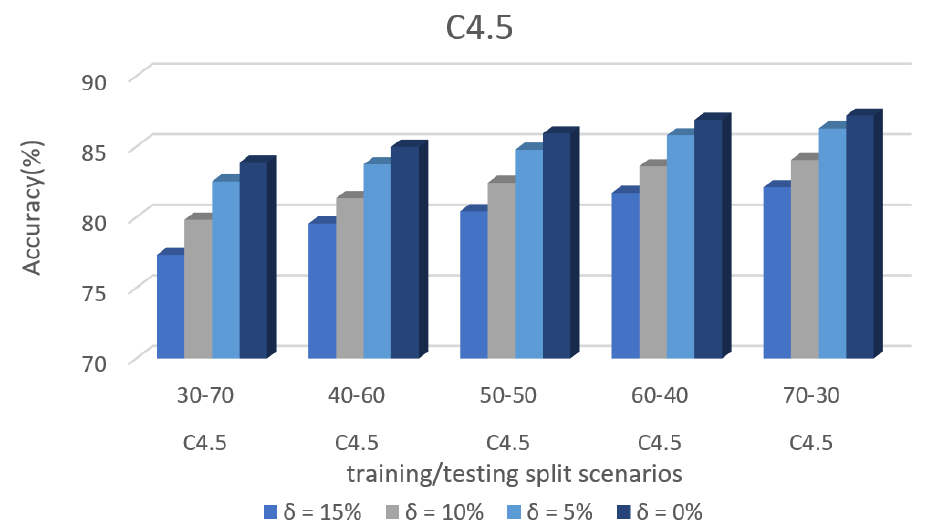
Figure 18. Accuracy Prediction for Dataset 3 using the C4.5 Algorithm.